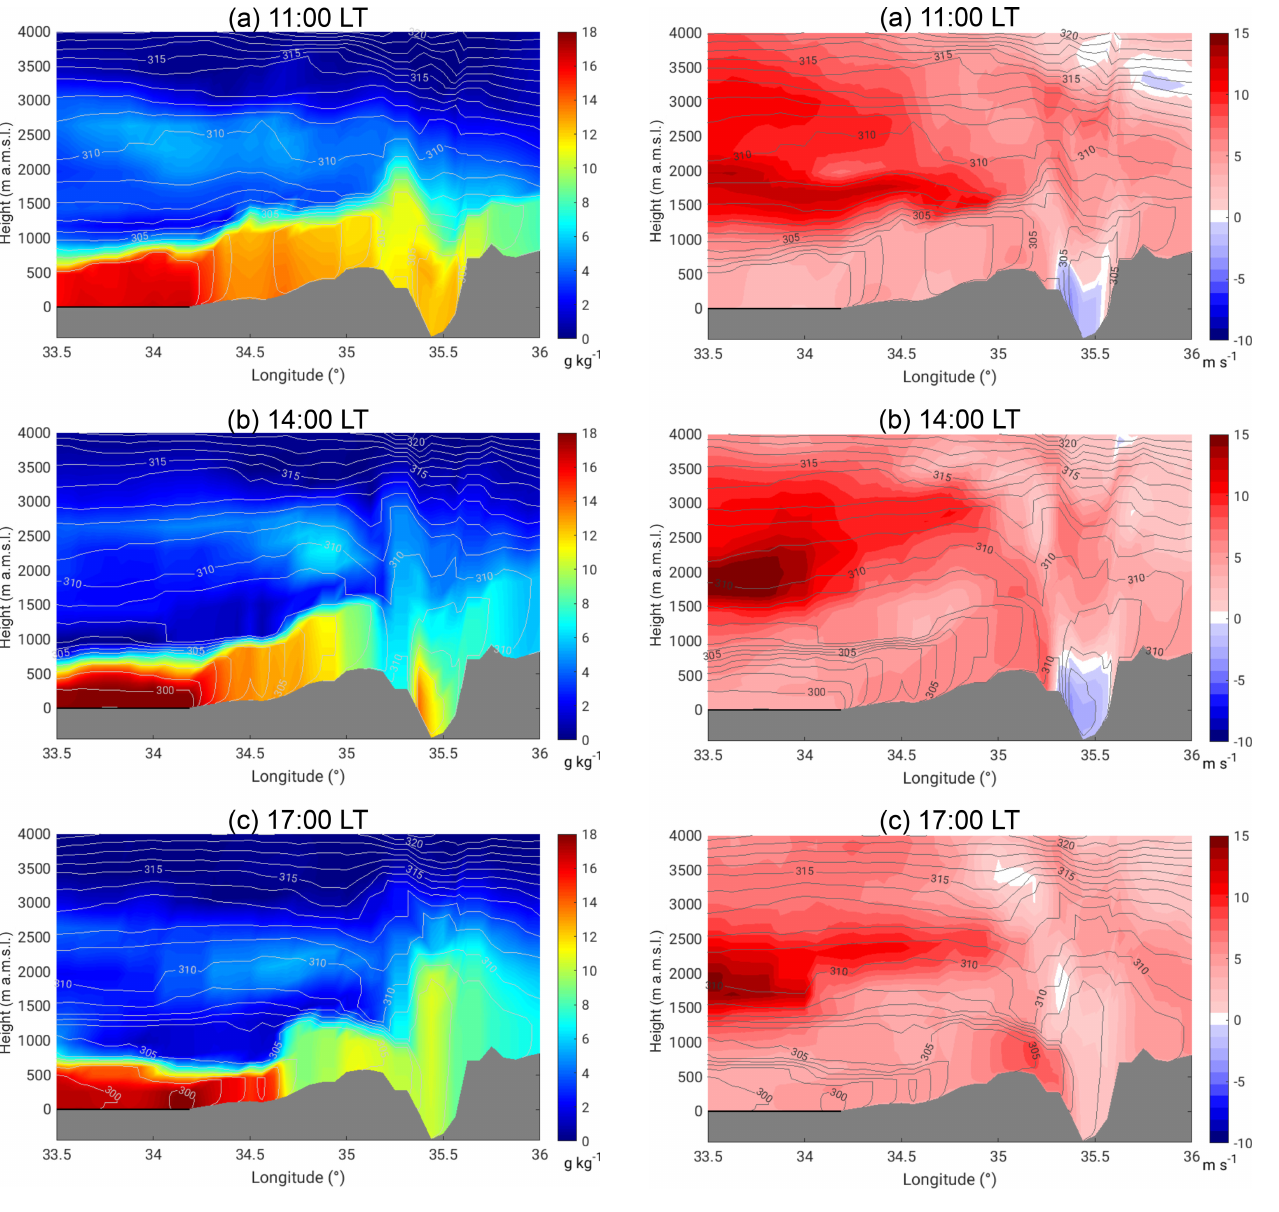
tential temperature increase of 3.3 K at around 270 m